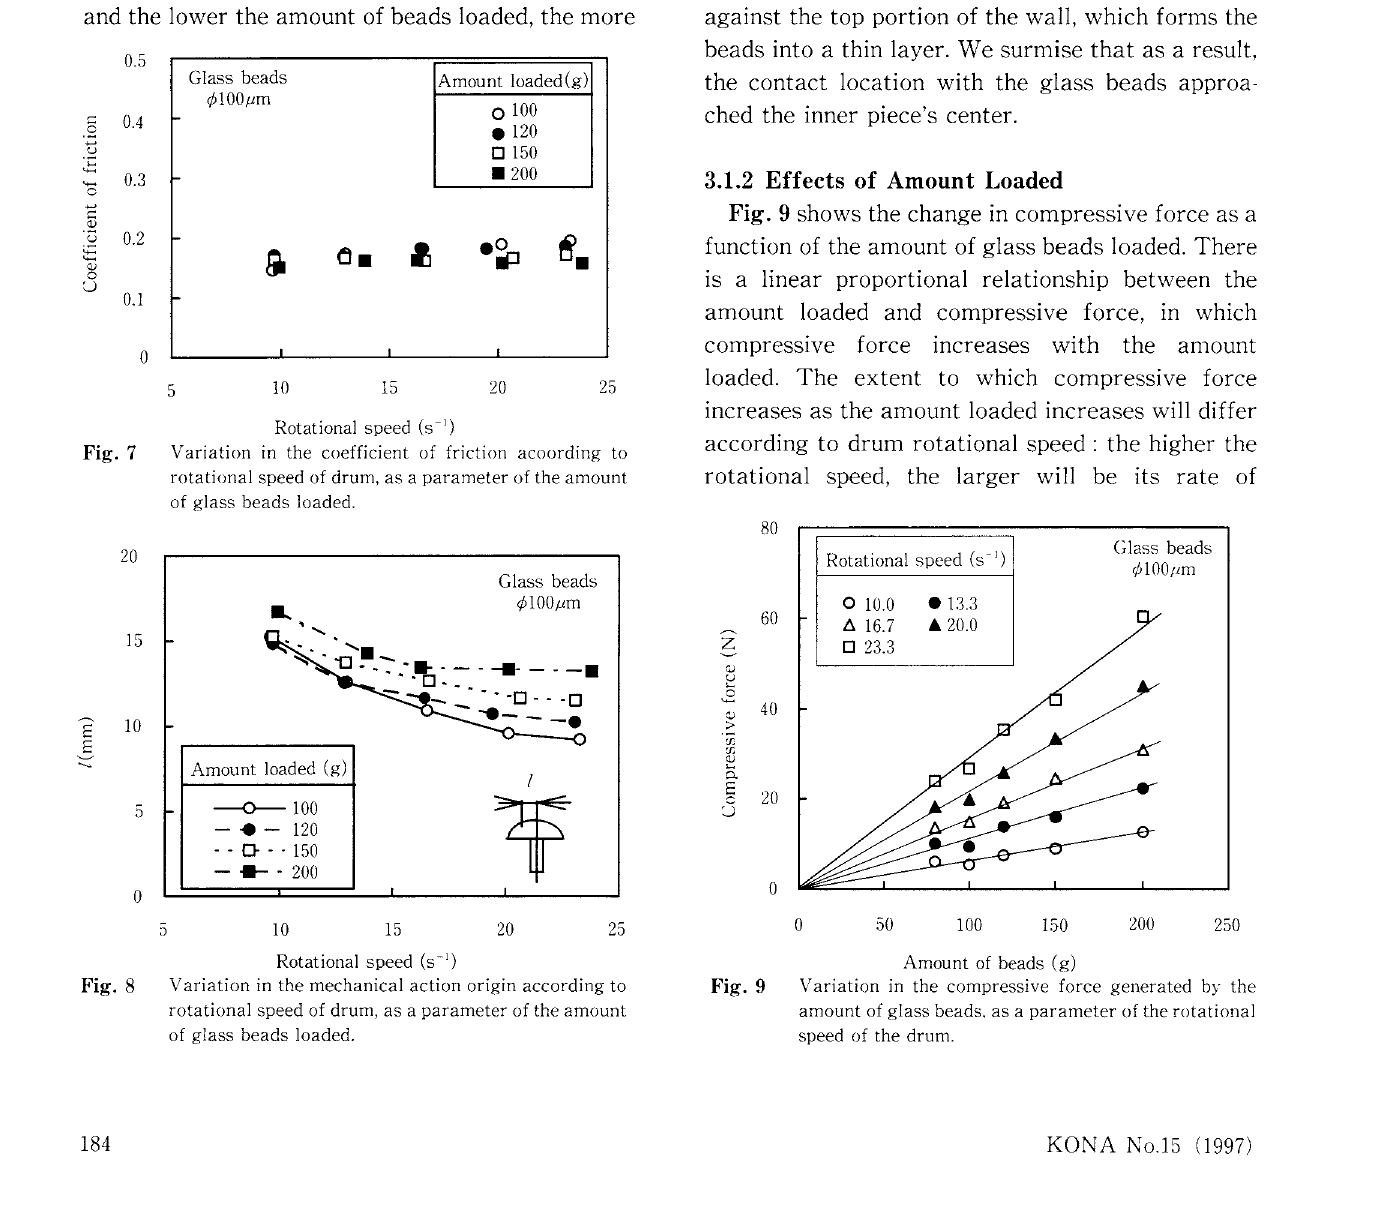
Variation in the mechanical action origin according to rotational speed of drum, as a parameter of the amount of glass beads loaded.